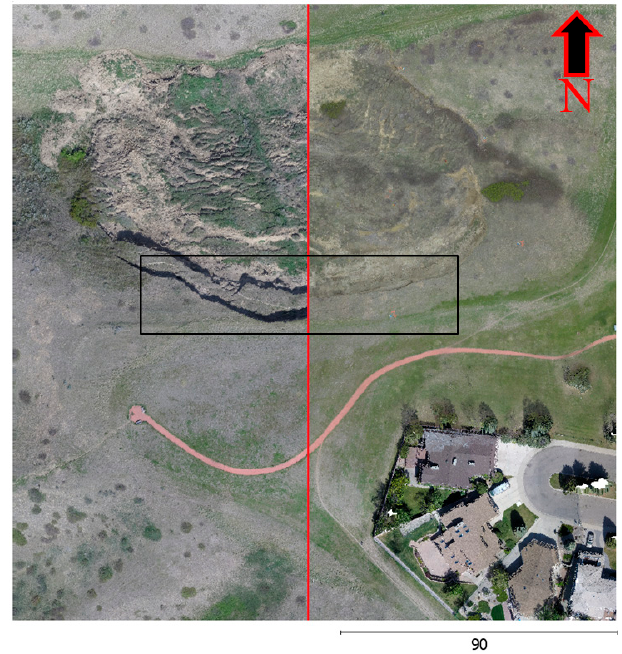
Figure 12. Visual comparison of the two periods, (Left, 2015) and (Right, 2014).